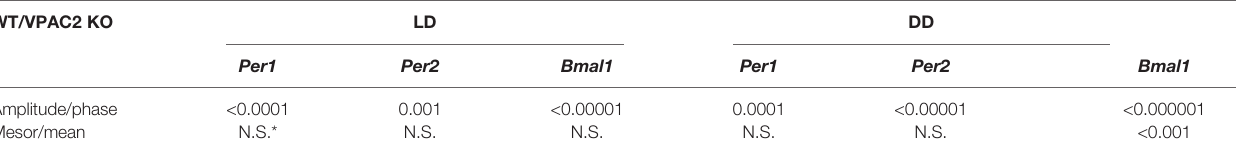
TABLE 2 | Signi fi cance of differences in rhythmometric parameters from Tables 1 and 3 between wildtype (WT) and VPAC2 receptor knockout mice (VPAC2 KO) during both light-darkness (LD) and constant darkness (DD). WT/VPAC2